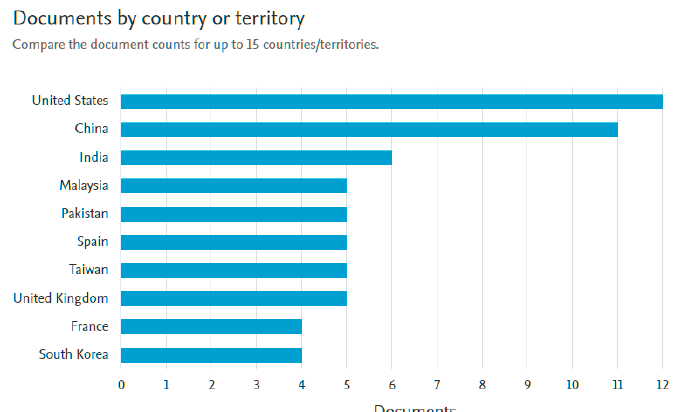
Figure 4. Results by year. Scopus.